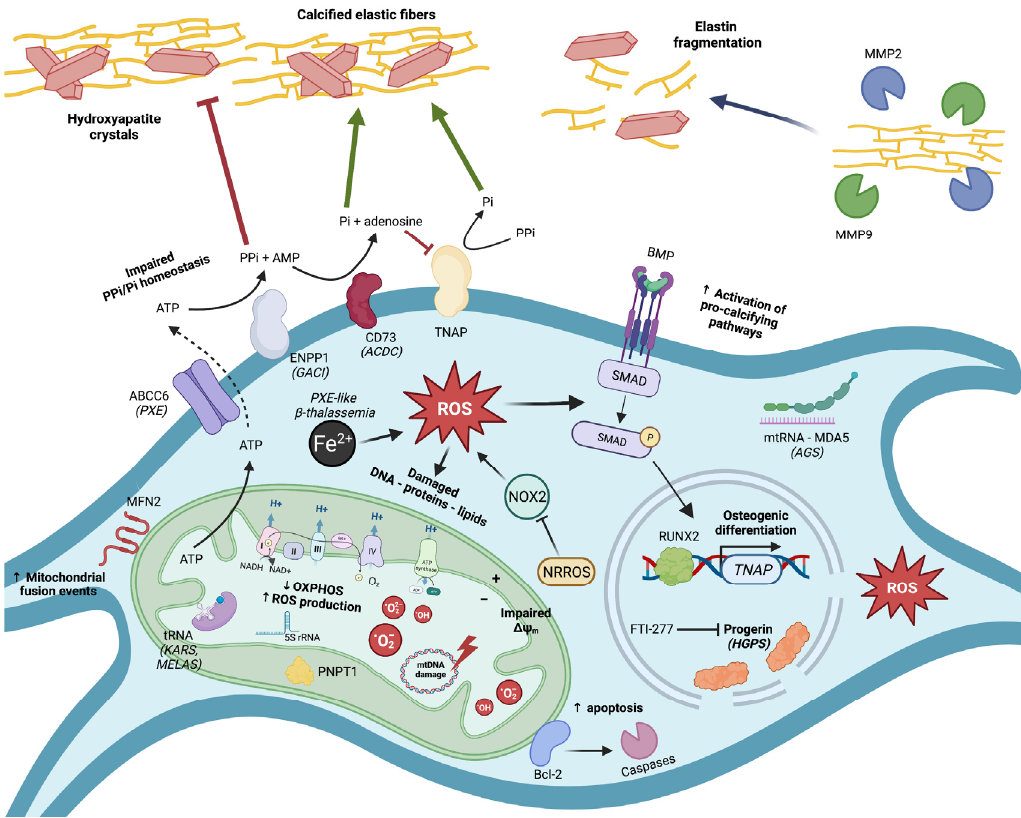
Figure 1. Graphical representation of key molecular pathways involved in mitochondrial dysfunc- tion, oxidative stress, and subsequent ectopic calcification. ABCC6 = ATP-binding cassette subfamily C member 6; ACDC = arterial calcification due to CD73 deficiency; AGS = Aicardi–Goutières syndrome; AMP = adenosine monophosphate; ATP = adenosine triphosphate; Bcl-2 = B-cell lymphoma 2; BMP = bone morphogenetic protein; CD73 = cluster of differentiation 73; ENPP1 = ectonucleotide pyrophosphatase/phosphodiesterase 1; FTI-277 = farnesyl transferase inhibitor-277; GACI = generalized arterial calcification of infancy; HGPS = Hutchinson–Gilford progeria syndrome; KARS = lysyl-tRNA synthetase 1; MDA5 = melanoma differentiation-associated protein 5; MELAS = mitochondrial encephalopathy, lactic acidosis and stroke-like episodes; MFN2 = mitofusin 2; MMP = matrix metalloproteinase; mtRNA = mitochondrial ribonucleic acid; NAD = nicotinamide adenine dinucleotide; NOX2 = NADPH oxidase 2; NRROS = negative regulator of ROS; OXPHOS = oxidative phosphorylation; Pi = inorganic phosphate; PNPT1 = polyribonucleotide nucleotidyltransferase 1; PPi = inorganic pyrophosphate; PXE = pseudoxanthoma elasticum; ROS = reactive oxygen species; rRNA = ribosomal ribonucleic acid; RUNX2 = runt-related transcription factor 2; SMAD = suppres- sor of mothers against decapentaplegic; TNAP = tissue-nonspecific alkaline phosphatase; tRNA = transfer ribonucleic acid.